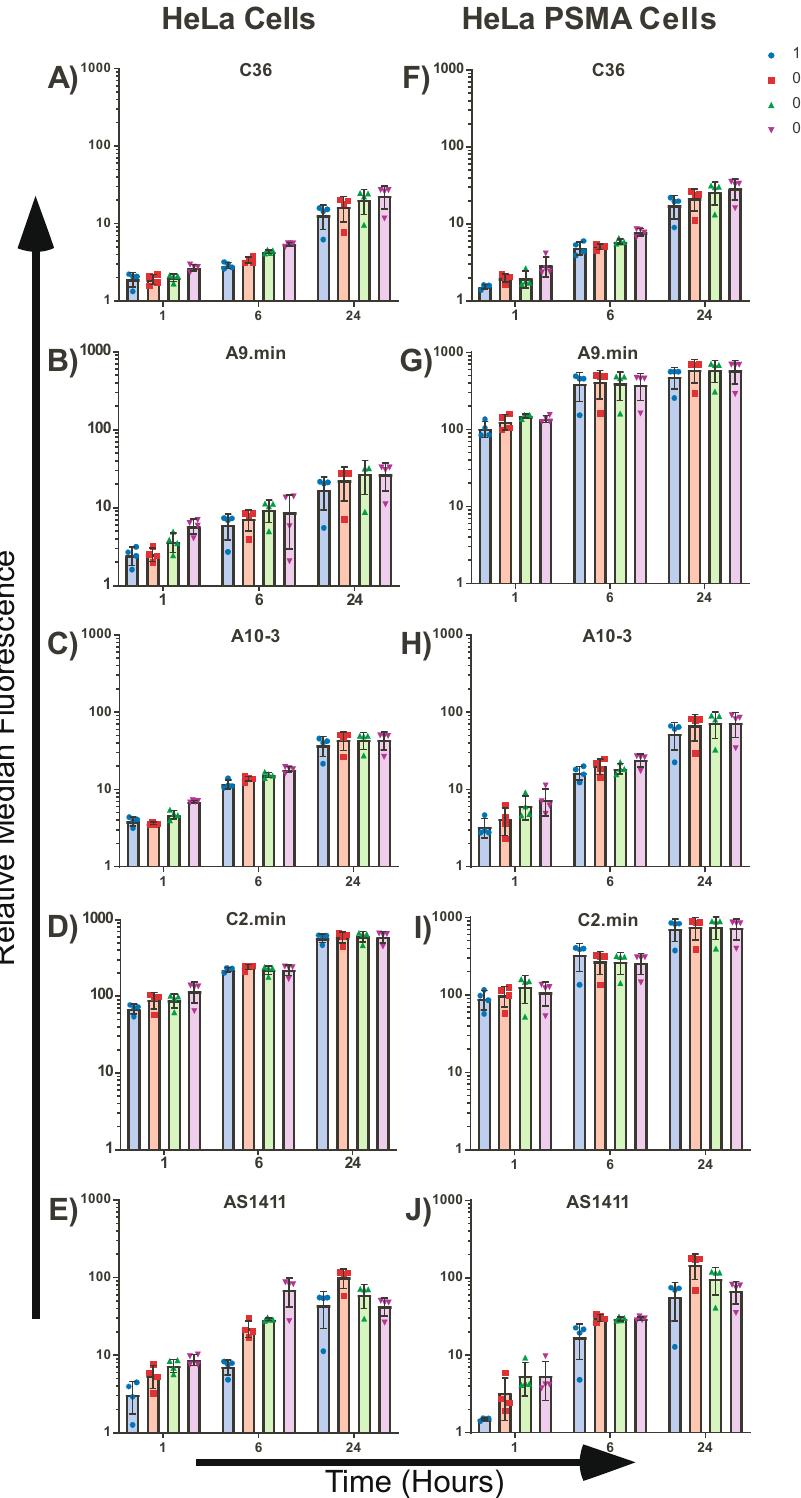
Fig. 1 Effects of time and blocking on aptamer uptake. Aptamers labeled with DY650 were incubated at 37 °C with HeLa and HeLa-PSMA cell lines at 500 nM in full growth media with increasing concentrations of ssDNA as a non-speci fi c inhibitor. Cells were allowed to bind/internalize the aptamers for 1, 6, or 24 h. The median fl uorescence signal of each aptamer is shown relative to unstained cells. HeLa cells with A C36, B A9.min, C A10-3, D C2.min, E AS1411 and HeLa PSMA cells with F C36, G A9.min, H A10-3, I C2.min, J AS1411. Bar color corresponds to the concentration of added ssDNA. Purple = no competitor, green = 0.01 mg/mL, red = 0.1 mg/mL, and blue = 1.0 mg/mL. Flow cytometry histograms for the corresponding data can be found in Supplementary Figs. 2 – 6. Data represents the mean of four experimental replicates ±SD. Source data are provided as a Source Data fi